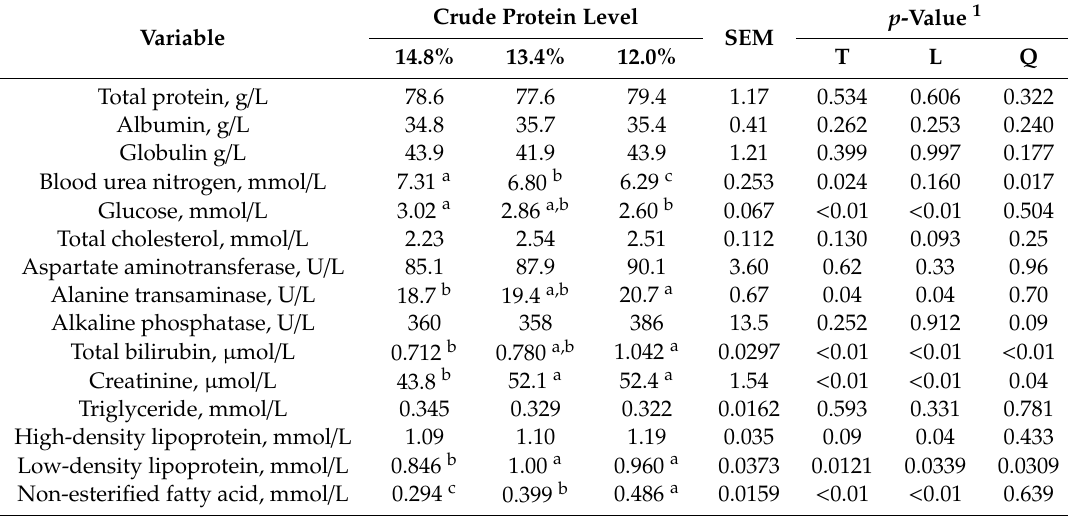
Table 3. E ff ects of low-protein diet on serum metabolites in growing goat kids.